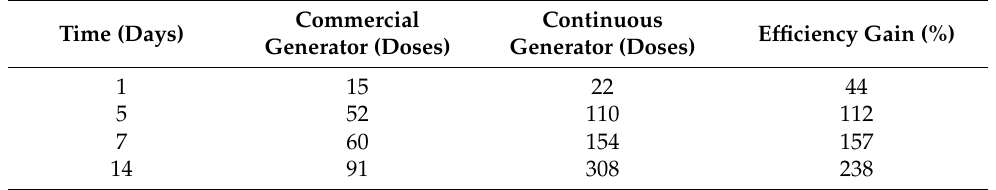
Table 2. Comparison of 99m Tc dose output (740 MBq) for a neutron generator (2 × 10 10 n/s) for the standard commercial 99 Mo/ 99m Tc generator production model after 1-week of irradiation ( A 0 = 16.6 GBq), whereby the target is decoupled from the source of production, versus continuous production at saturation (~5-half-lives; A saturation = 19.4 GBq), where only the 99m Tc is removed from the irradiated target. Assumptions do not account for 99m Tc at EOB, generator elution efficiency, nor decay losses due to